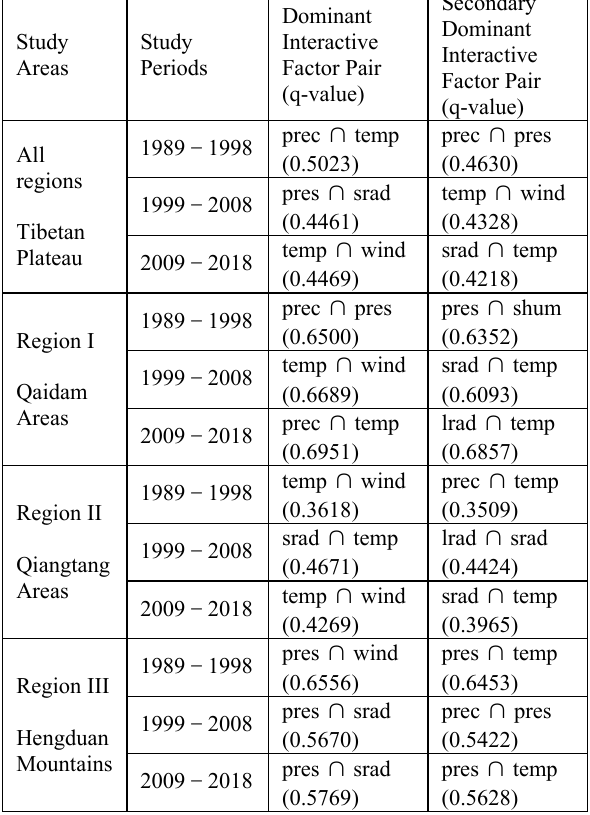
Table 2 . Dominant interactional climatic factor pairs of snow cover variations for the whole plateau and three climatic